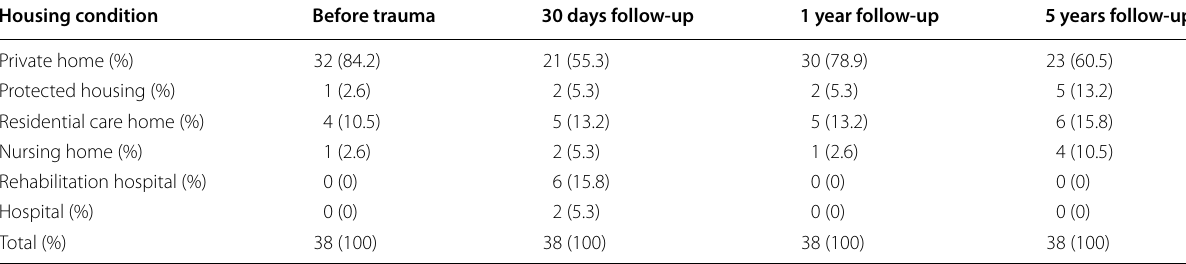
Table 3 Housing conditions during a 5-year